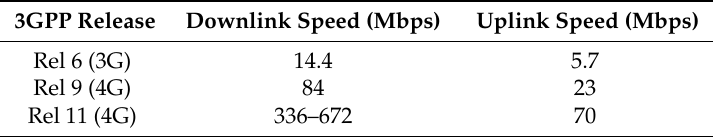
Table 2. 3G/4G maximum